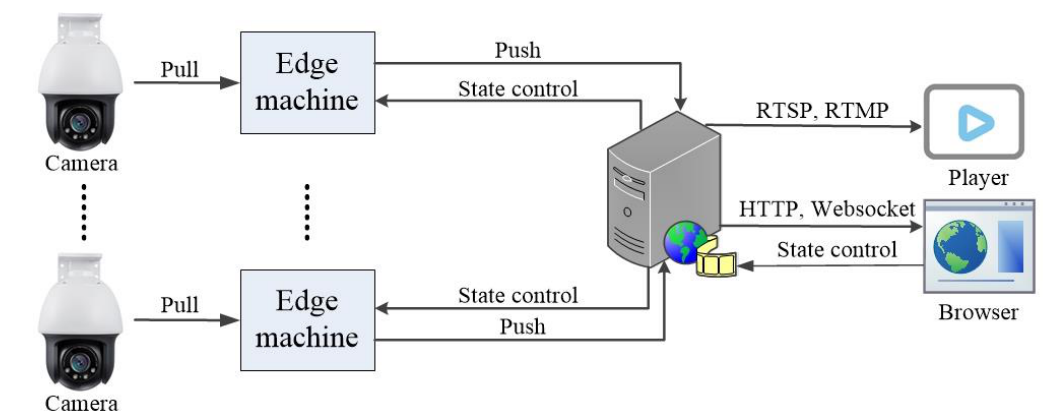
Figure 8. Cloud-edge collaboration architecture.